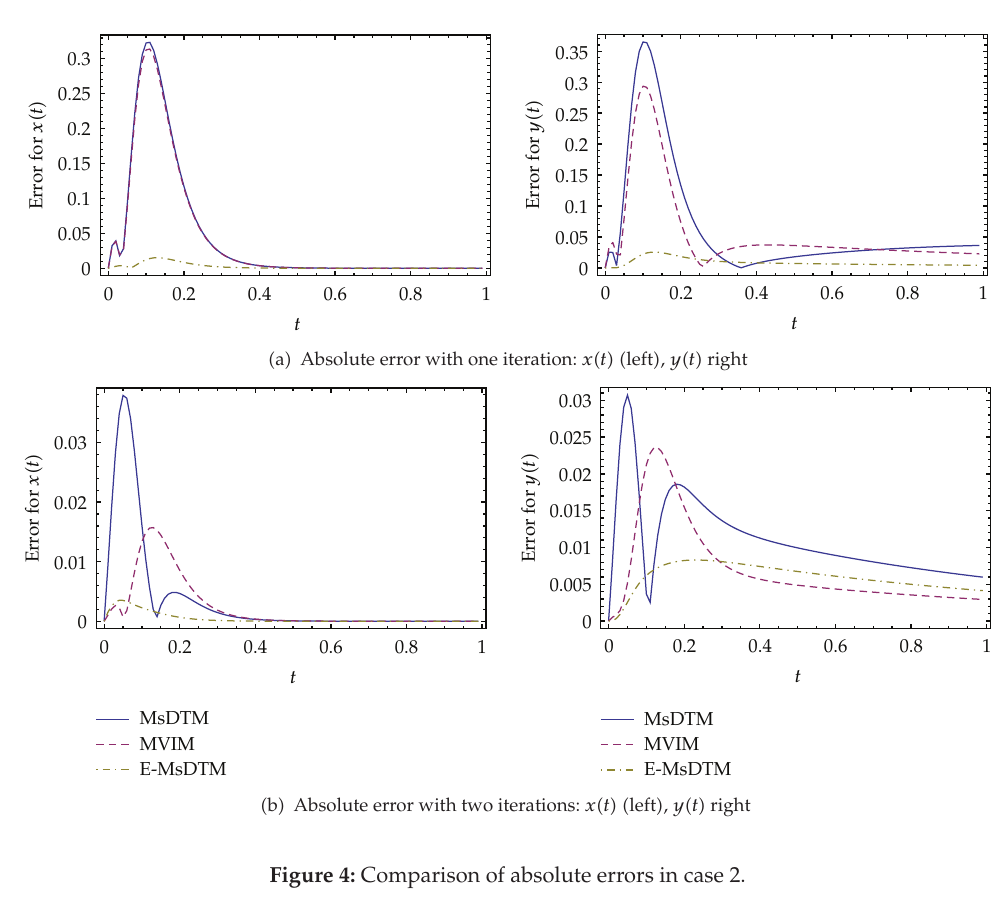
Figure 4: Comparison of absolute errors in case 2.